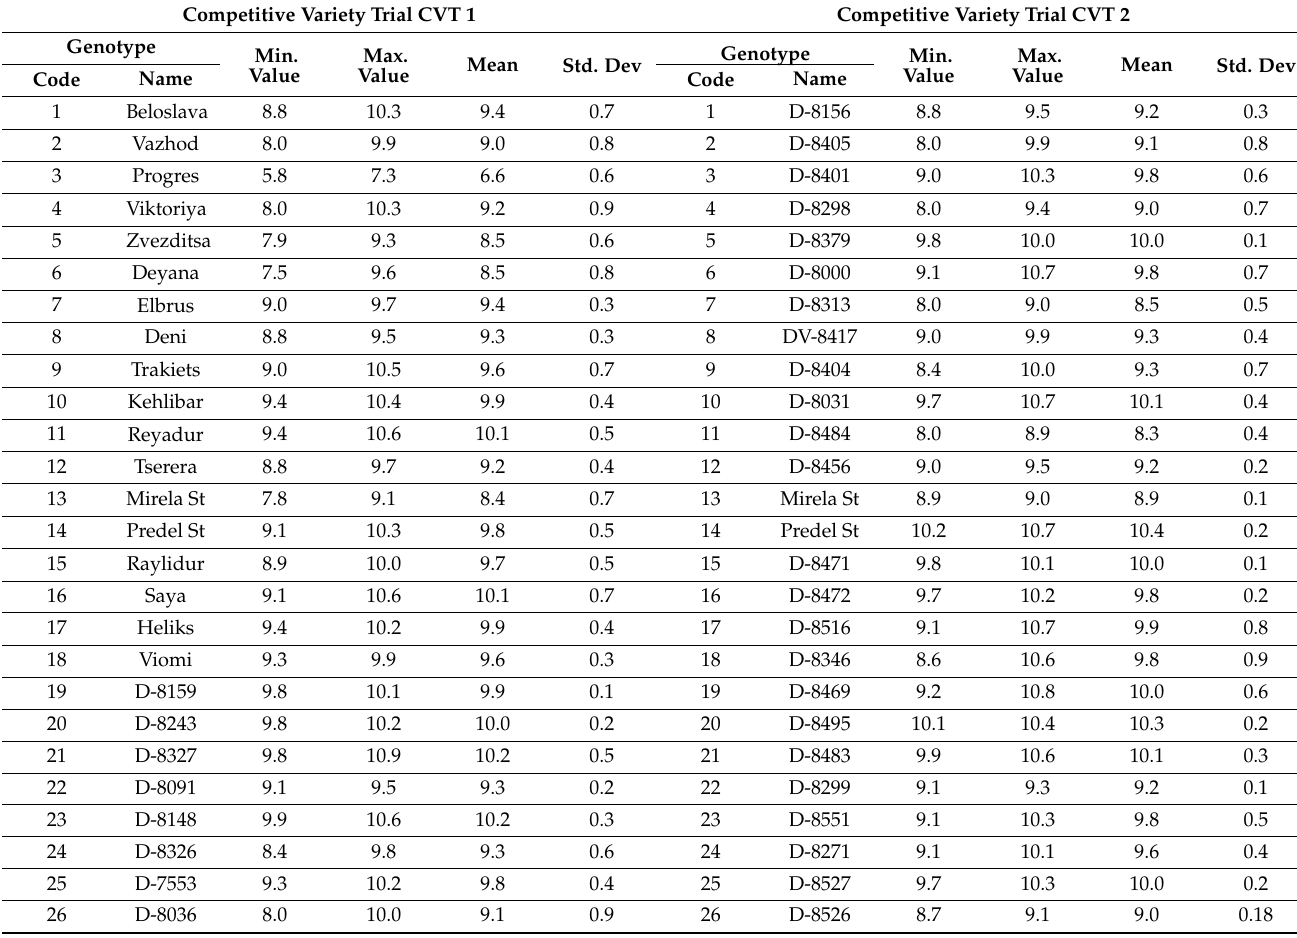
Table A1. Location of the varieties and breeding lines in CVTs and descriptive statistics for the ground-measured data for the GY (kg/plot) from each genotype. A plot is 13.2 m 2 (12 × 1.10